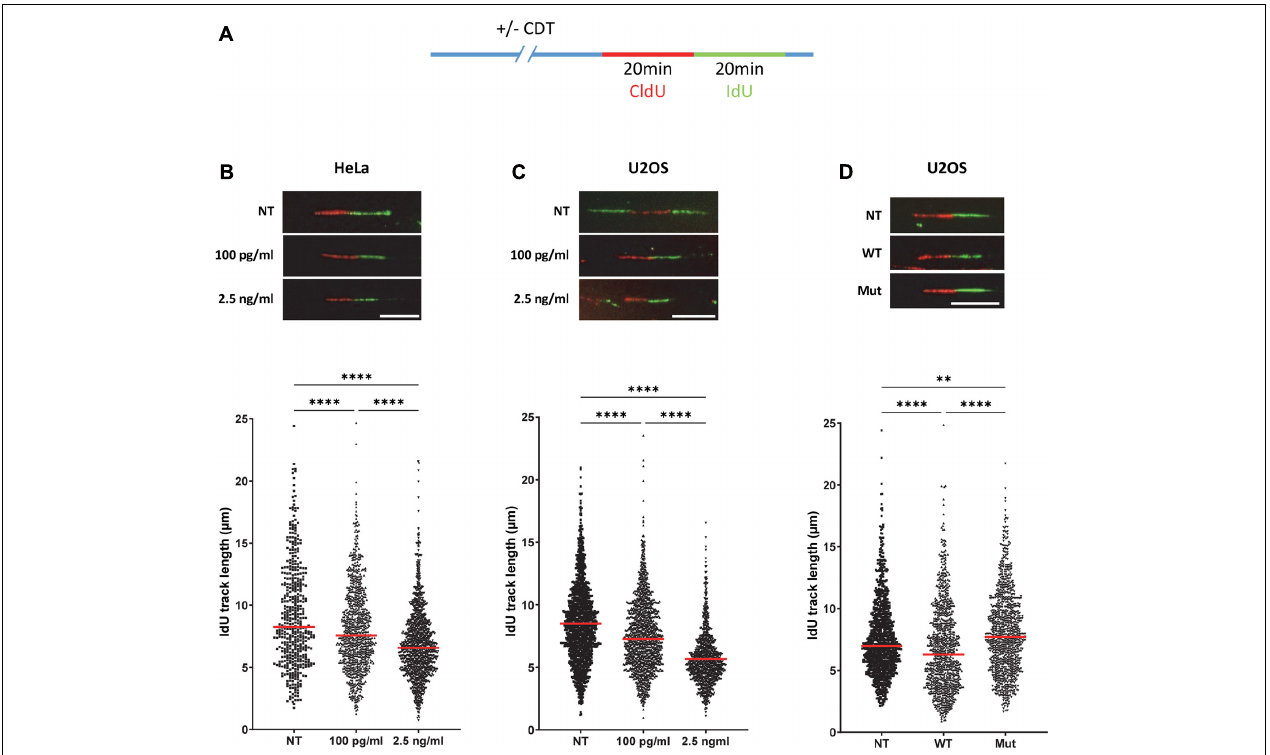
FIGURE 1 | The catalytic activity of cytolethal distending toxin (CDT) induces a replicative stress. (A) Cells were incubated or not with CDT holotoxins during several hours before successive pulse labeling with 5-chlorodeoxyuridine (CldU) and 5 iododeoxyuridine (IdU). Then, replication fork speed was analyzed by DNA fiber assay. IdU track length was determined. (B–D) Upper panel: representative images of replication tracks: CldU (red) and IdU (green) ( n > 400 IdU tracks were measured with a wide-field fluorescent microscope, original magnification × 40, scale bar: 10 µ m). Lower panel: horizontal red lines represent the median (** P < 0.01, **** P < 0.0001). (B) HeLa cells were treated or not (NT) with 100 pg/ml or 2.5 ng/ml of CDT from E. coli for 16 h before IdU and CldU staining. (C) U2OS cells were treated or not with the same doses of CDT from H. ducreyi for 24 h before the replication staining. (D) U2OS cells were treated or not with 2.5 ng/ml of wild-type (WT) or catalytically inactive mutant (Mut) of CDT from H. ducreyi for 24 h before IdU and CldU